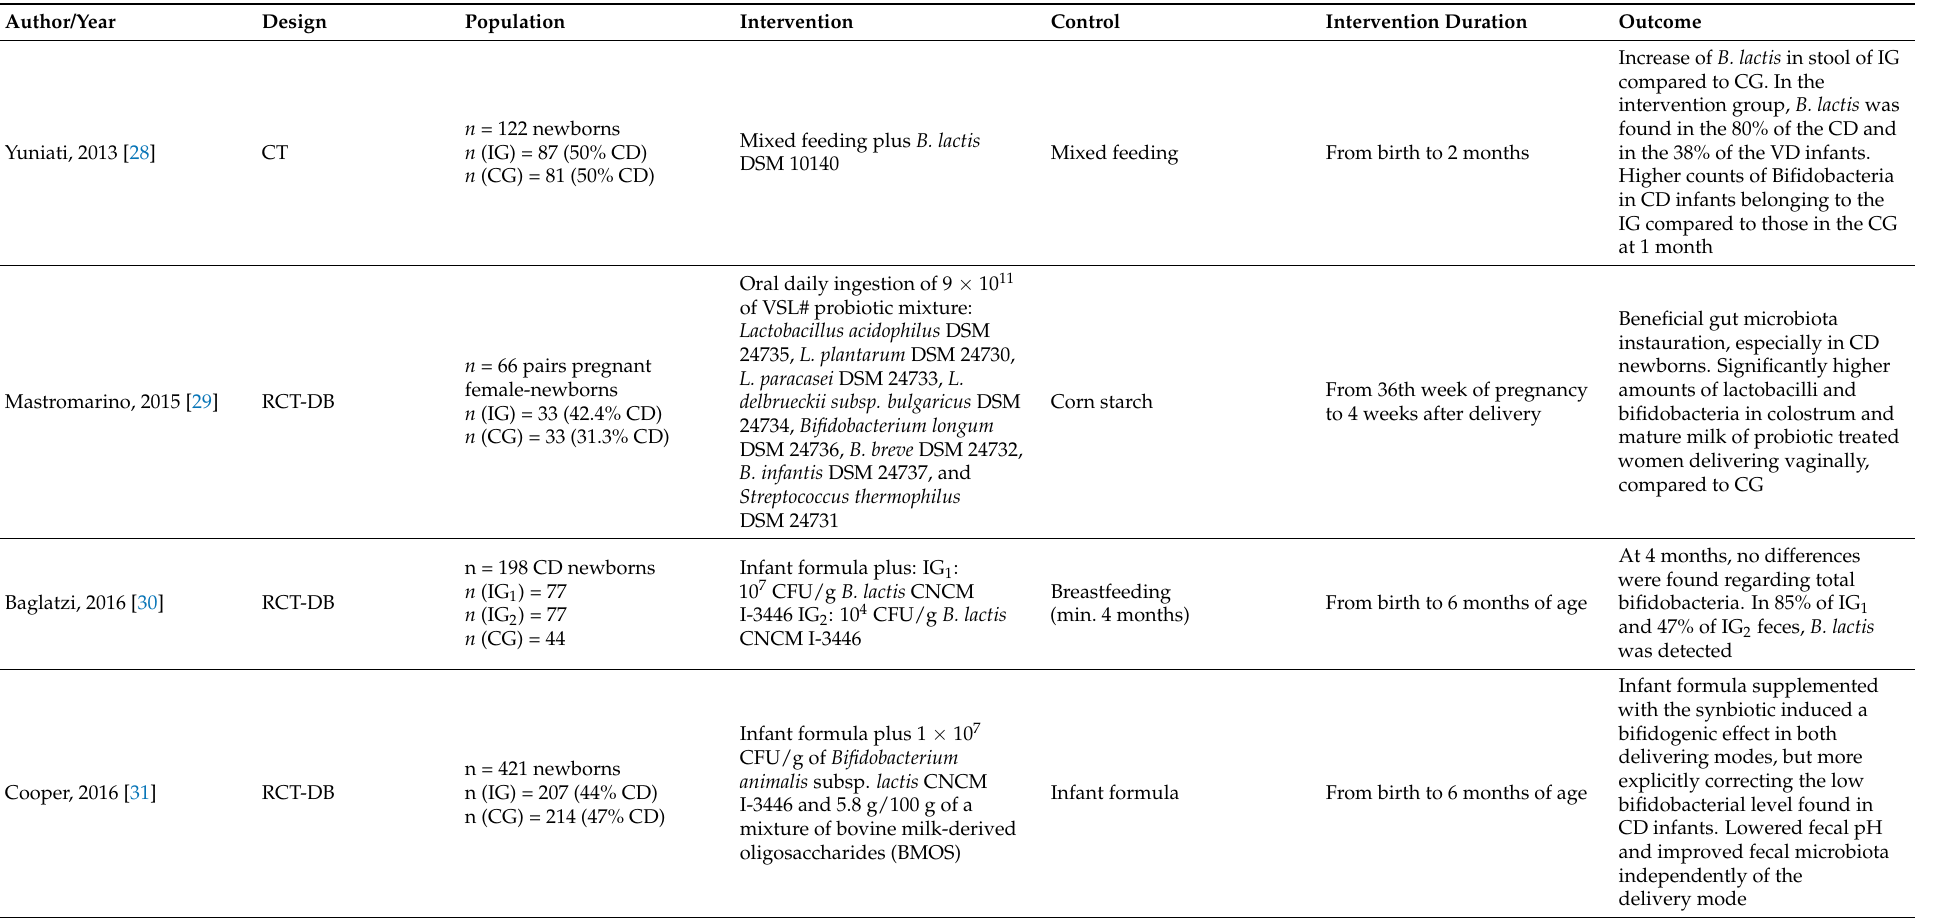
Table 1. Characteristics of the studies